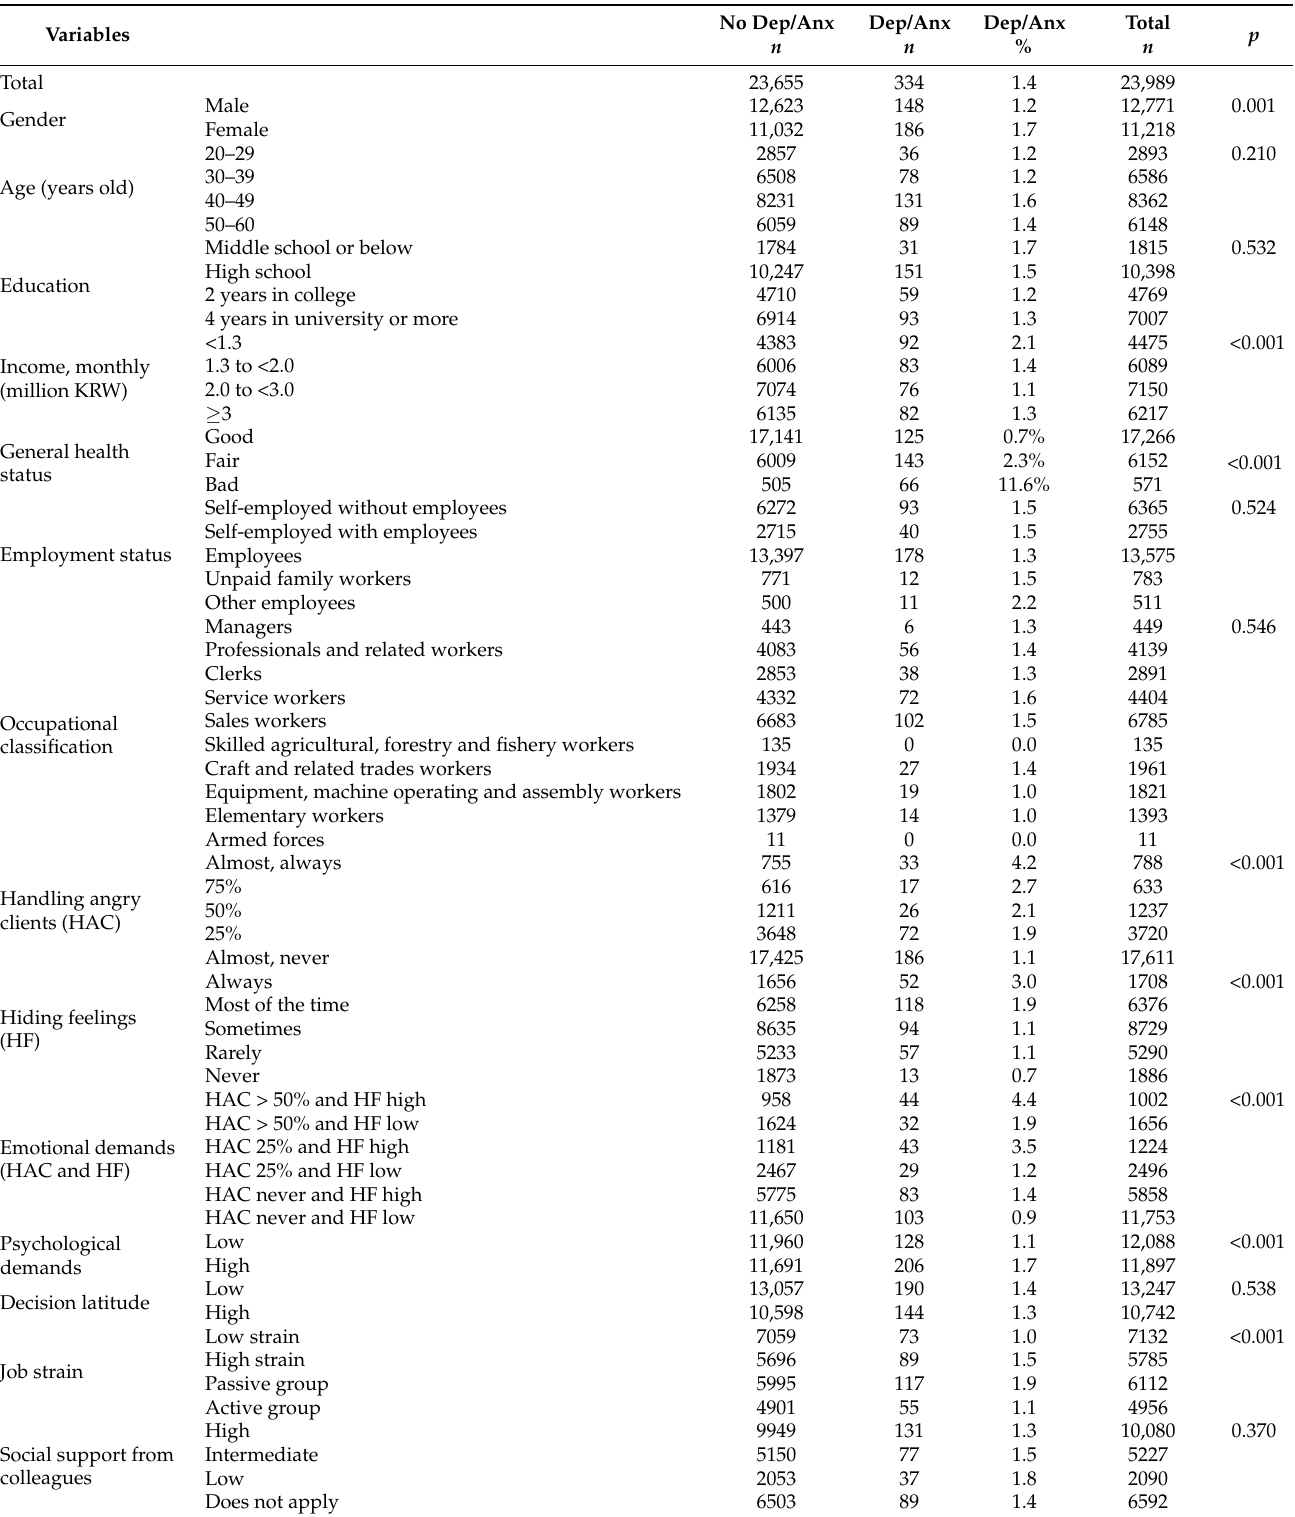
Table 1. Demographic characteristics and psychosocial factors at work among Korean client-facing workers by mental health